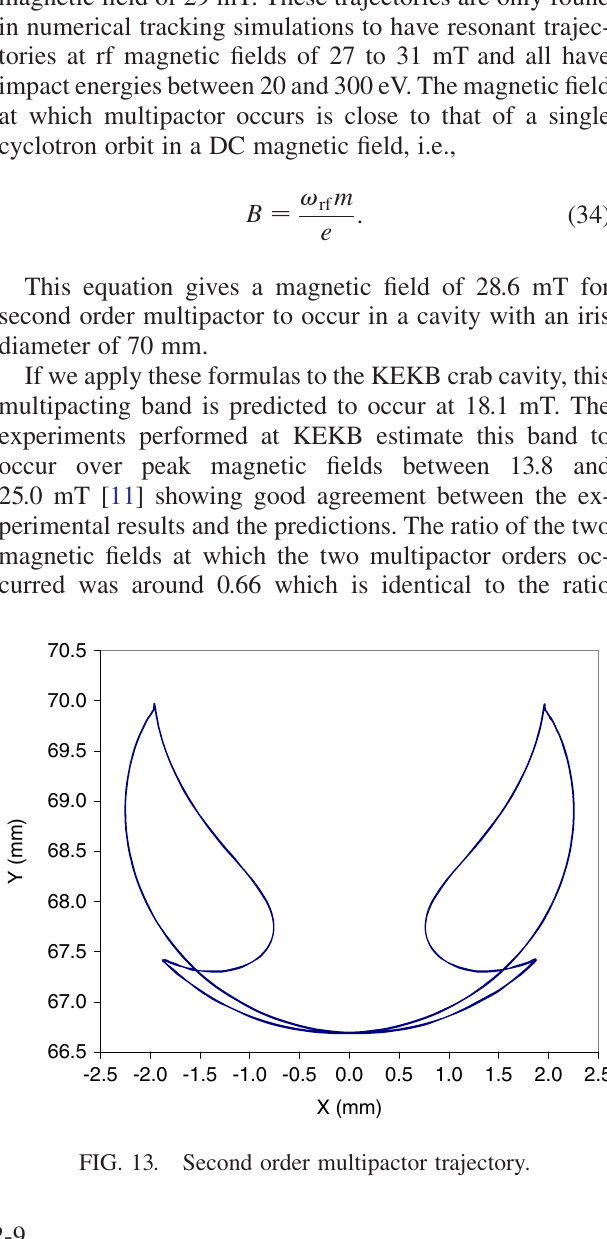
FIG. 12. Comparison between the numerically calculated im- pact energy and the analytically predicted, for multipactor in a rf deflecting cavity with an iris of 70 mm radius.